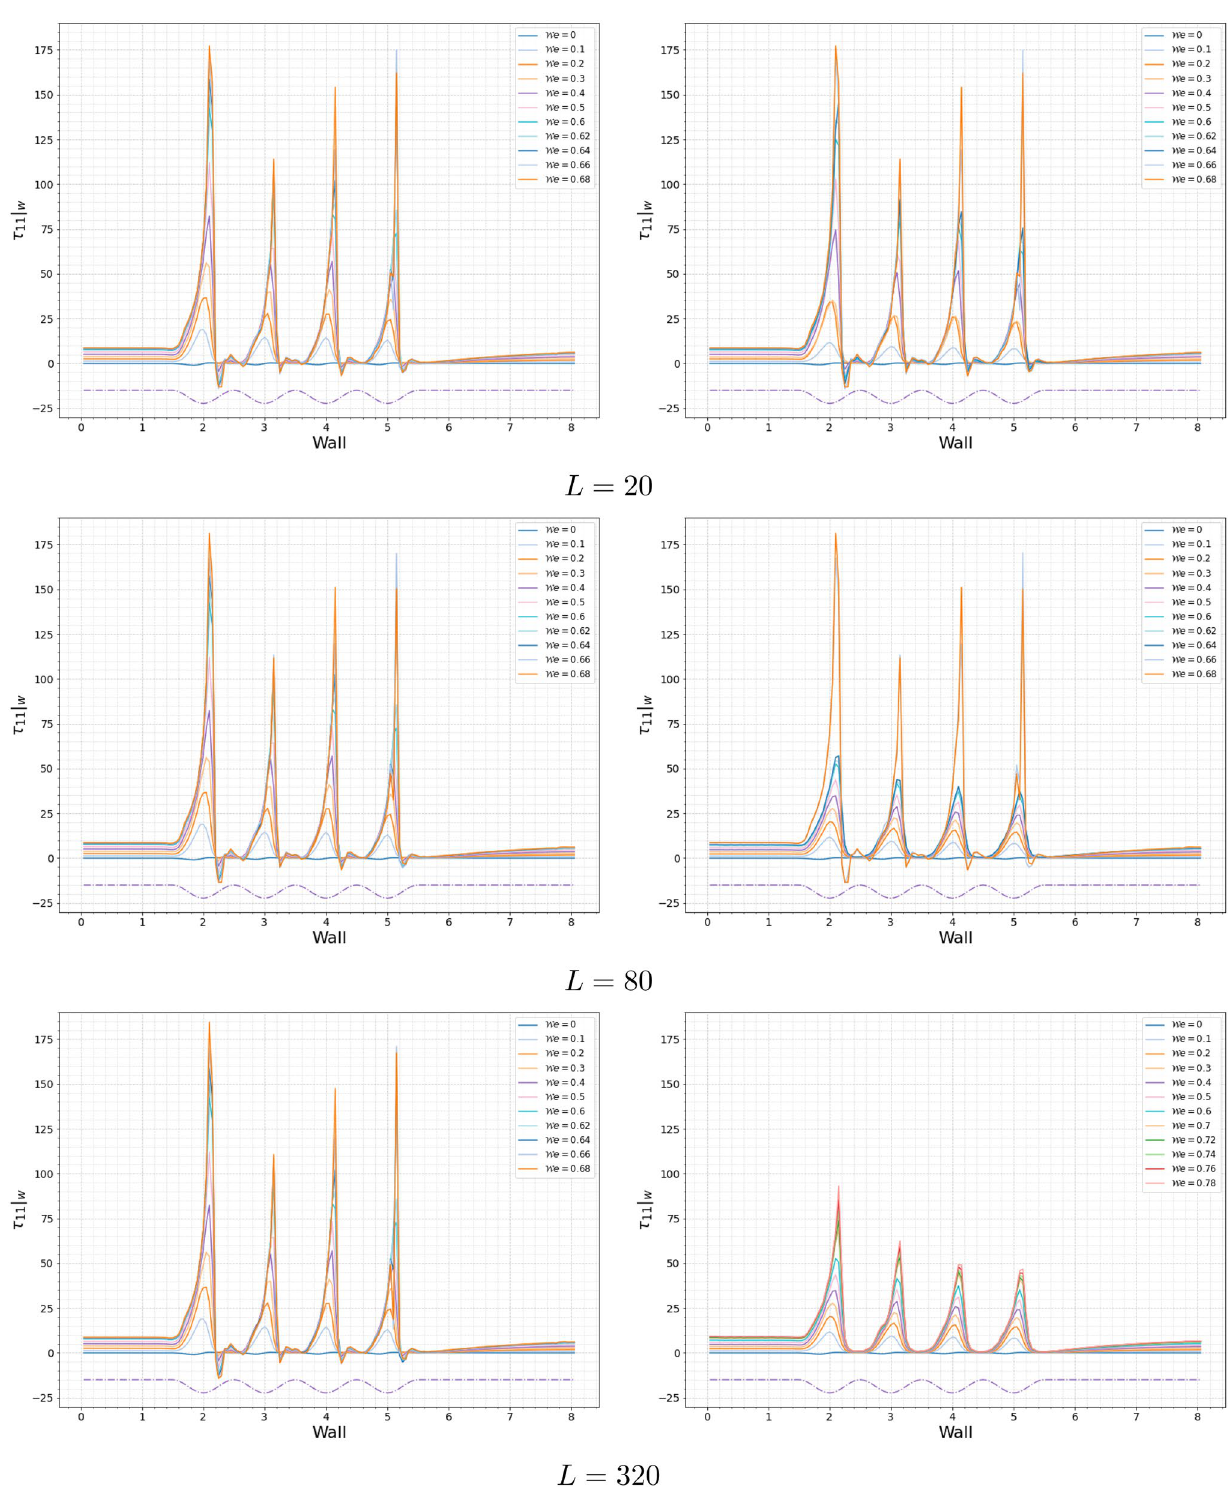
𝝉 ) (left) and 𝛼 ( ) (right) for differ- p t t ‖ ‖ ‖ ‖